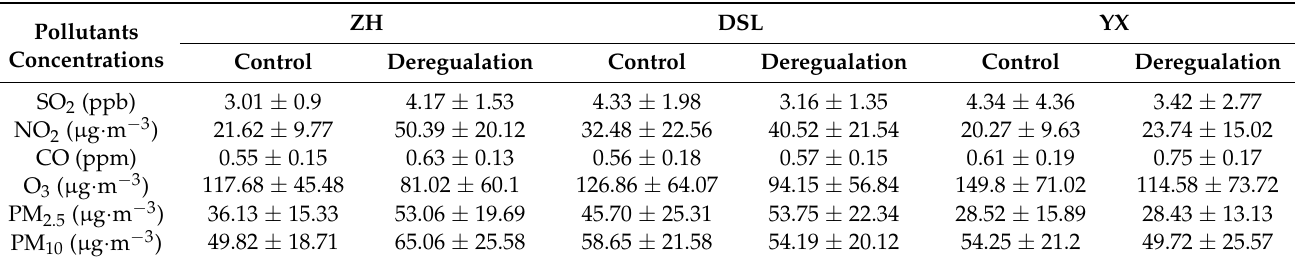
Table 3. The concentrations of pollutants (SO 2 , NO 2 , CO, O 3 , PM 2.5 and PM 10 ) during different periods at the ZH, DSL and YX